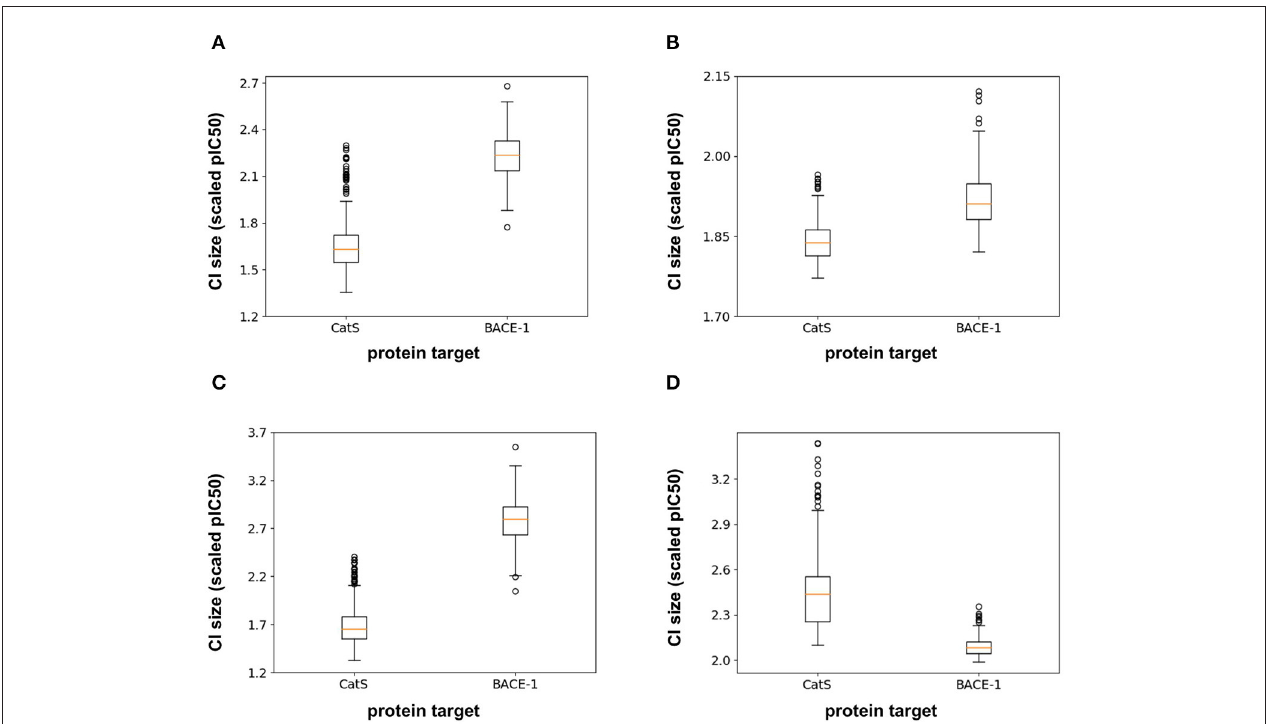
FIGURE 5 | Box-whisker plots of the 95% confidence interval (CI) sizes (scaled pIC50) for CatS/BACE-1 predictions for (A) RF PCM model, (B) PCM FFN model, (C) QSAR RF model, and (D) QSAR FFN